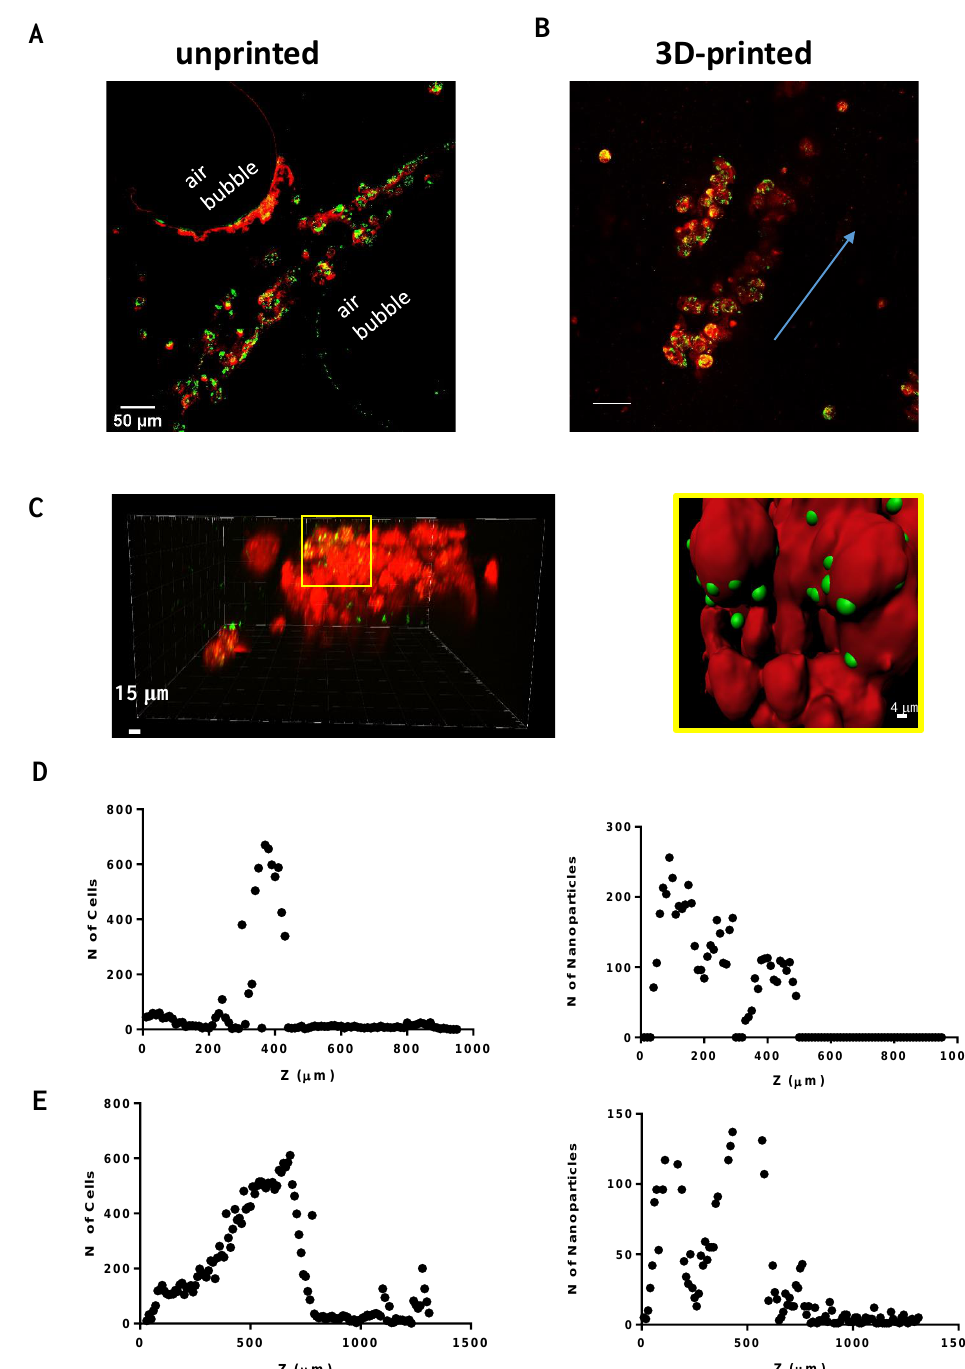
Figure 6. Nanoparticle diffusion in the uncontrolled deposition (unprinted) and printed OBST. Microscopical images on unprinted ( A ) and printed ( B ) hydrogel showing NP (green) and Calu-3 (red) interaction, respectively, in cell-laden multilayers (from top (0) to bottom (1500 µ m)). Blue arrow: cell growth direction. ( C ) Left: a portion of a 3D-printed multilayer. Right: rendered image of the yellow zoom shown in the left panel. NP internalization from the cells. ( D ) Left: cell distribution in the unprinted hydrogel. Right: NP diffusion in the unprinted hydrogel. ( E ) Same as ( D ) for 3D-printed